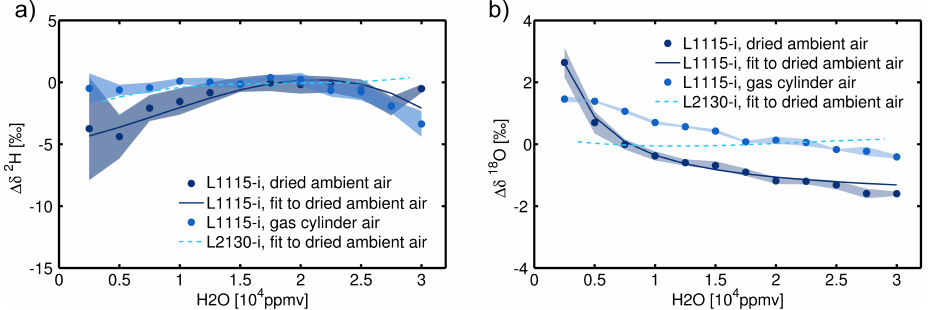
Fig. 6. Dependency of the L1115-i isotope measurements on water vapour mixing ratio for δ 2 H in (a) and δ 18 O in (b) . The data were calibrated independently using the WVISS calibration unit and the IAEA standards VSMOW2 and SLAP2 at a water vapour mixing ratio of 18000ppmv. The shading represents the standard deviation of all calibration runs with four different working standards (WS 6–9 in Table 2). The full blue curves are least square fits to the data obtained using dried ambient air as a carrier gas. The dashed curves show least square third order polynomial fits to the L2130-i